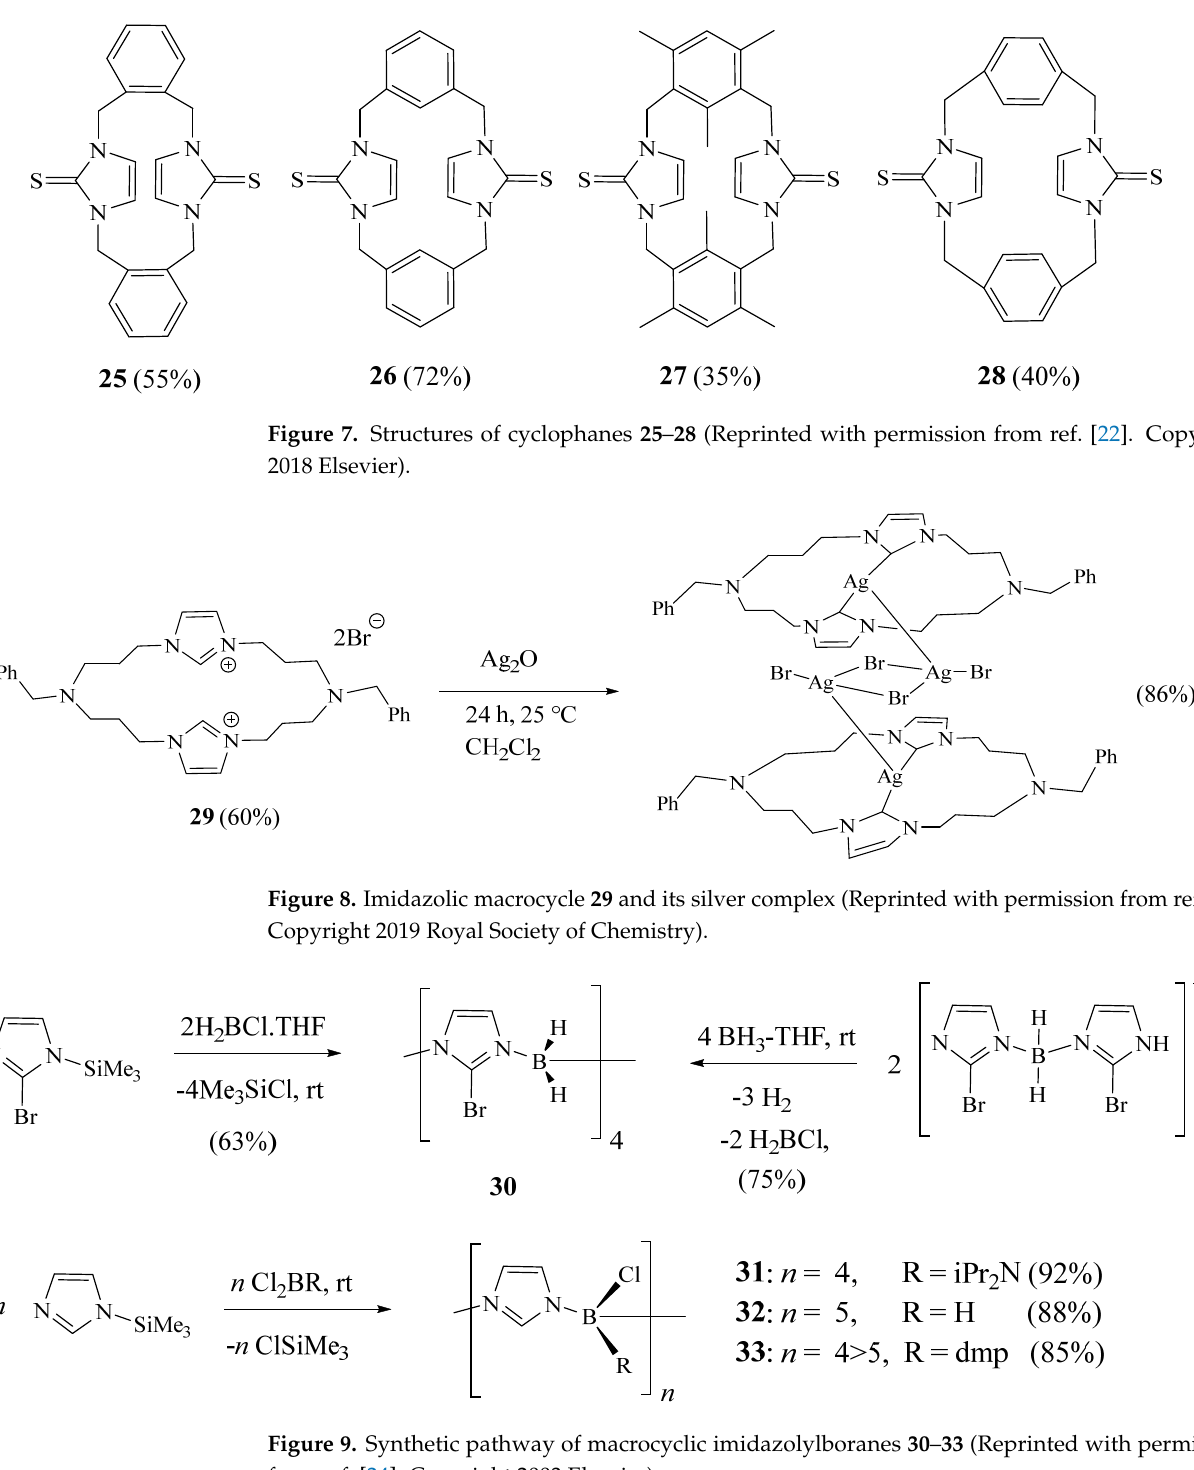
Figure 10. Tetrameric boron–imidazole macrocycles 34 and 35. (Reprinted with permission from ref. [25]. Copyright 2012 Elsevier). Sargent et al. [26] described the synthesis, spectroscopic properties, and computa- tional analysis of an imidazole-based analogue of porphycene—namely, ‘imidacene’ 37. The reductive coupling of a diformyl-substituted 2,2 ′ -biimidazole using low-valent tita- nium gives the intermediate macrocycle 36. This step was followed by treatment with 2,3- dichloro-5,6-dicyano-1,4-benzoquinone (DDQ) (Figure 11). This macrocycle was found to un- dergo rapid decomposition, even in the absence of light and air. Through high-level theoreti- cal calculations, they explained this instability by the presence of a delocalised 18 π –electron pathway in both imidacene and porphycene that provides less aromatic stabilisation energy. Figure 11. Synthetic route of macrocycle 37. (Reprinted with permission from ref. [26]. Copyright 2003 John Wiley and Sons).